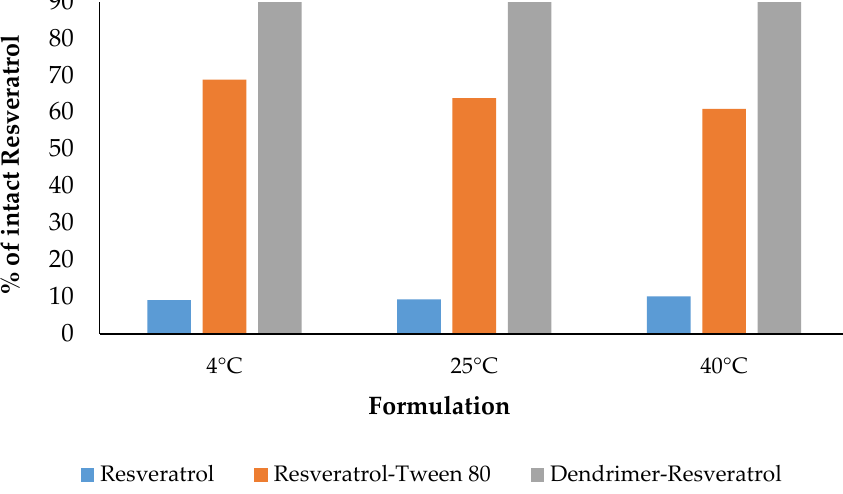
Figure 8. Percentage of intact resveratrol remaining in the formulations after Day 1.